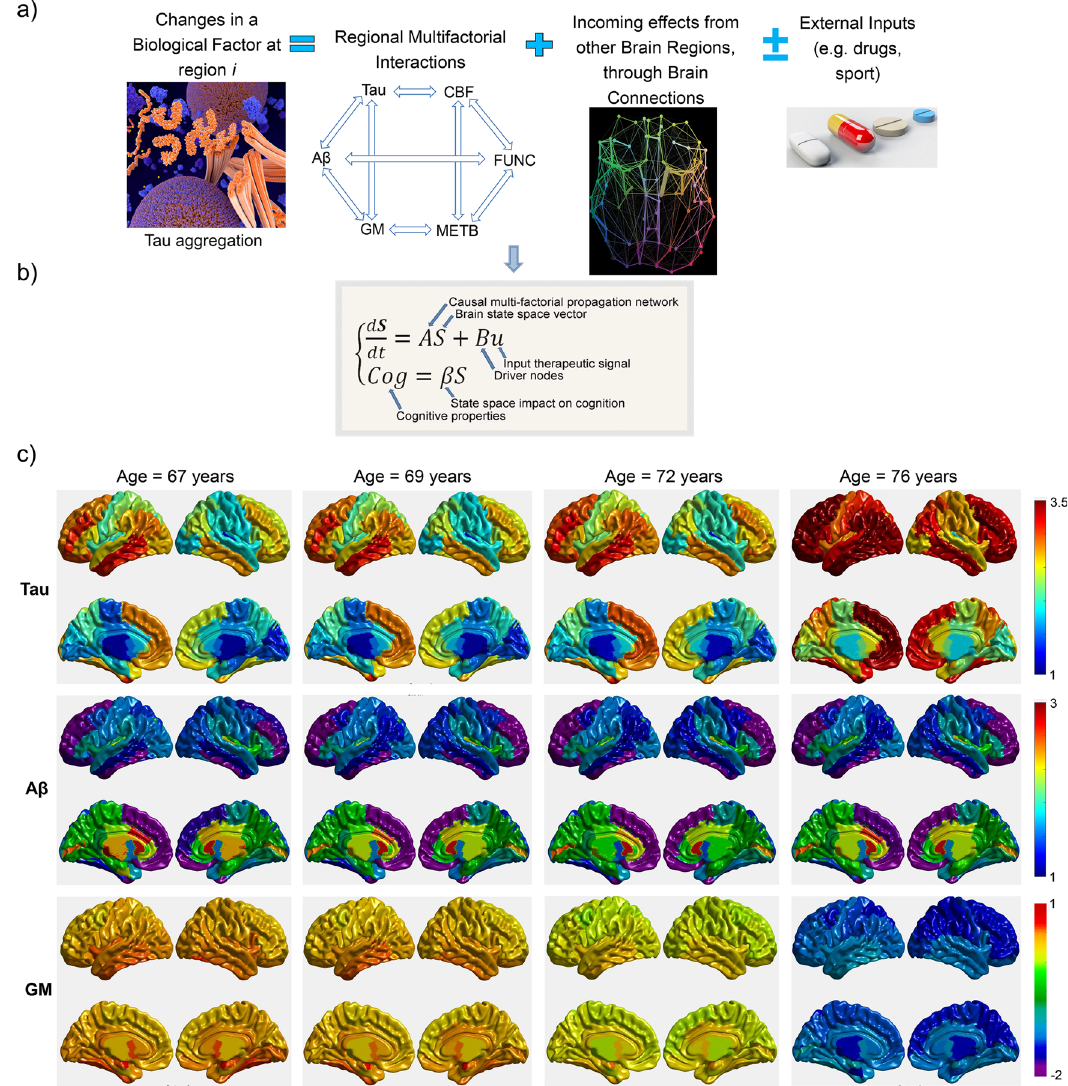
Fig. 4 MCM de fi nition and prediction of concurrent tau, amyloid, and structural brain changes in preclinical AD. a Changes in a given biological